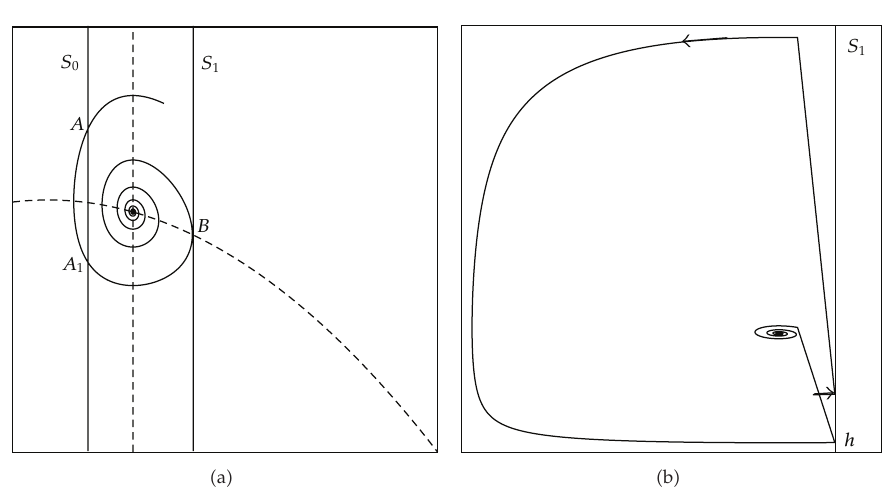
Figure 1: (cid:9) a (cid:10) Phase diagram of system (cid:9) 1.3 (cid:10) without impulses; (cid:9) b (cid:10) phase diagram of system (cid:9) 1.3 (cid:10)